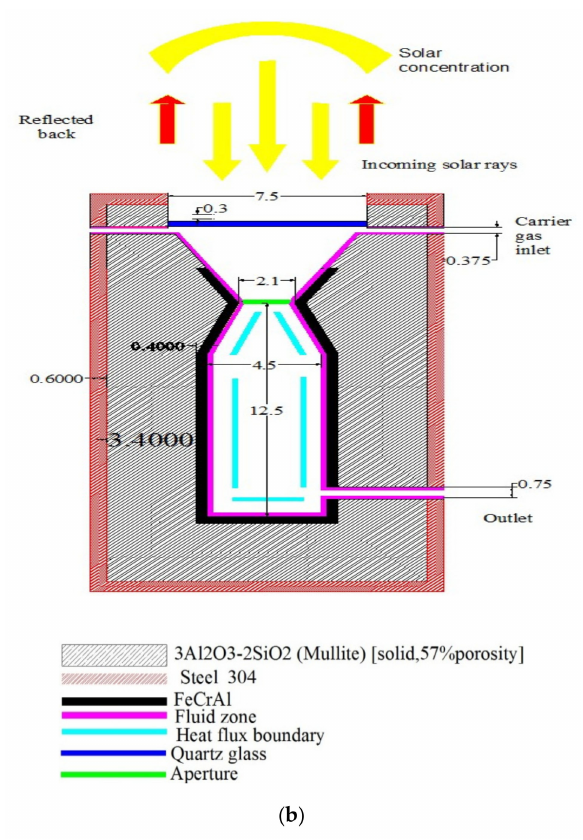
Figure 2. Schematic diagram of the heat storage reactor model: ( a ) Applied boundaries; ( b ) Computational domain used for the